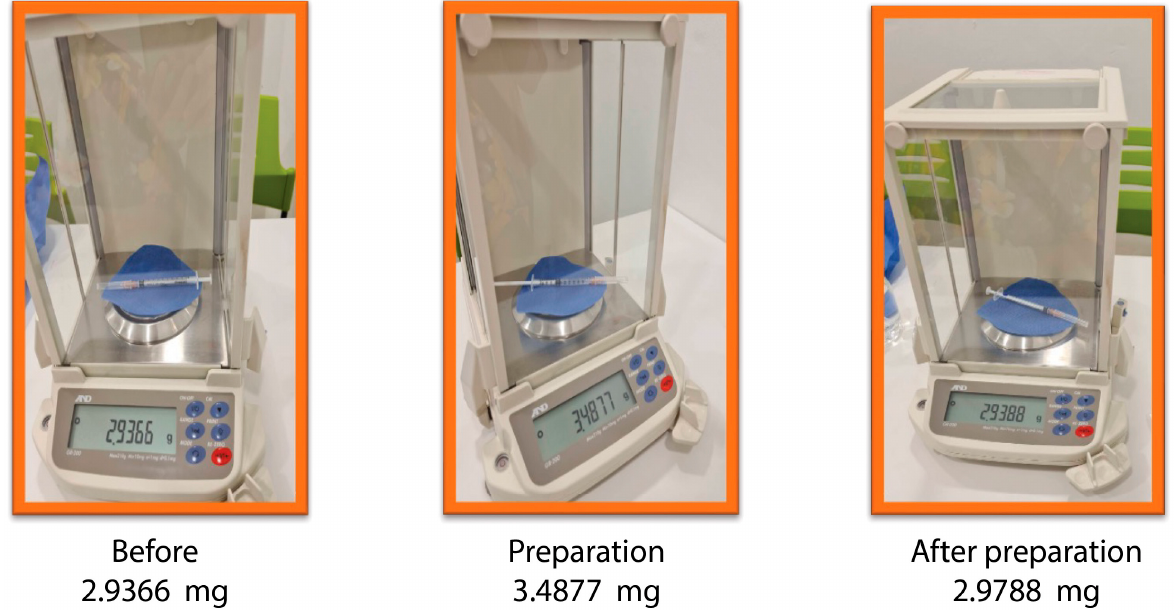
Figure 3. Comparison of vaccine weights by using the air-filled technique. Before: Weight of the empty syringe and needle. Preparation: Filled syringe with the vaccine. After preparation: Weights of the syringe and needle after